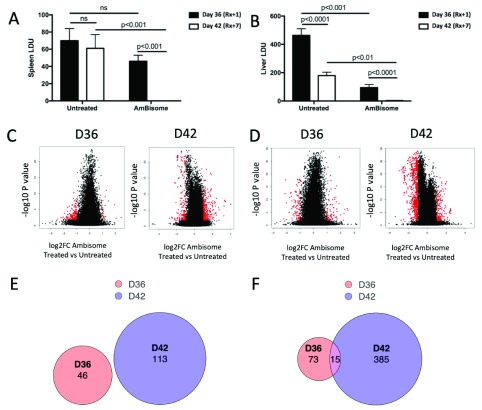
Transcriptional changes associated with AmBisome
® treatment in
L. donovani-infected BALB/c mice.Cohorts of weight matched female BALB/c mice were infected with ~2×10
7
L. donovani amastigotes and at day 35 randomised to receive AmBisome (8mg/kg) or saline (untreated).
A and
B. Parasite loads were determined in spleen (
A) and liver (
B) at day 36 (R
x+1) and day 42 (R
x+7). Data are shown as mean Leishman Donovan Units ± SEM (n=5 per group), with p values as indicated.
C and
D. Differentially expressed genes in spleen (
C) and liver (
D) are presented using a volcano plot, with red symbols indicating genes passing the FDR<0.05 and log2FC=1 cut off. Genes with positive DE are UP in AmBisome
®-treated vs. untreated mice and vice versa.
E and
F. Venn diagrams to indicate the number of up and down regulated genes and their overlap in spleen (
E) and liver (
F), comparing AmBisome
®-treated vs. untreated mice.